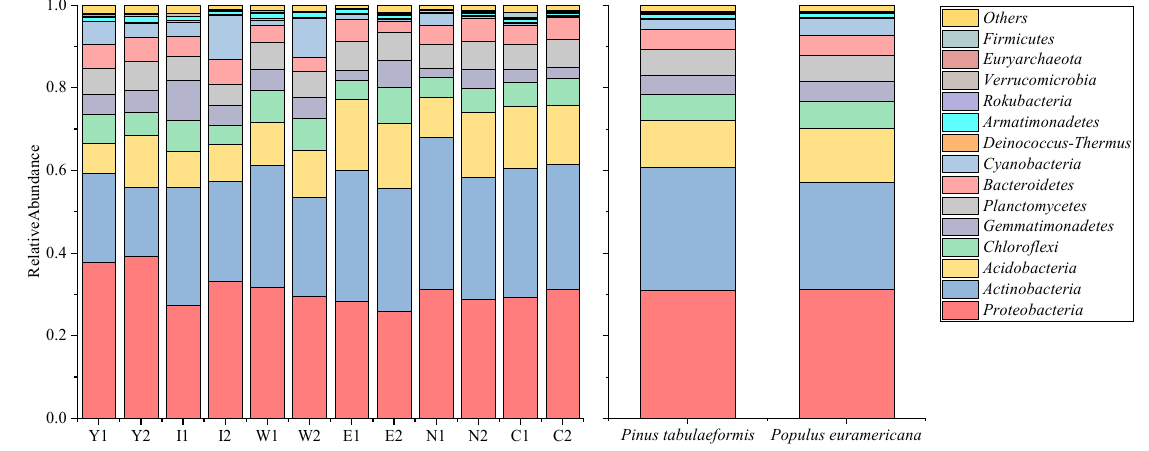
Figure 3. Composition and relative abundance of bacterial community at the phylum level of each sample in the Heidaigou open-pit coal mine dump and control area.